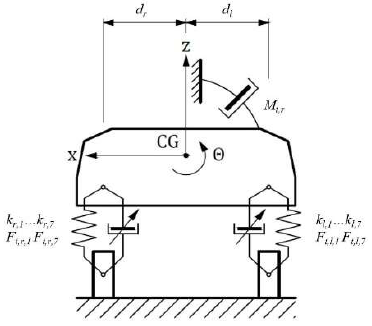
Figure 4. The rotational viscous damper—relevant for the body roll.